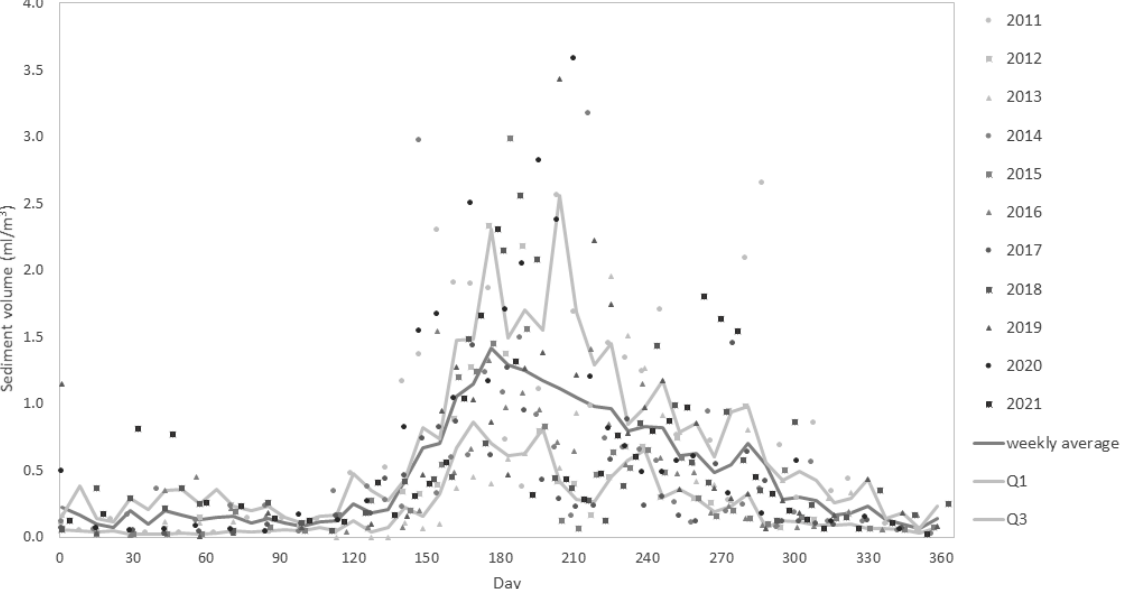
Figure 3. Comparison of the variations over one year for the sediment volume from 2011 to 2021 at location E1 of the study system. Sediment was collected in filters in place for one to two weeks (Table 1), and the volumes were normalized to a cubic meter of filtered water. The grey lines represent the weekly average, lower (Q1 to 25th percentile) and upper (Q3 to 75th percentile) quartiles of all data.